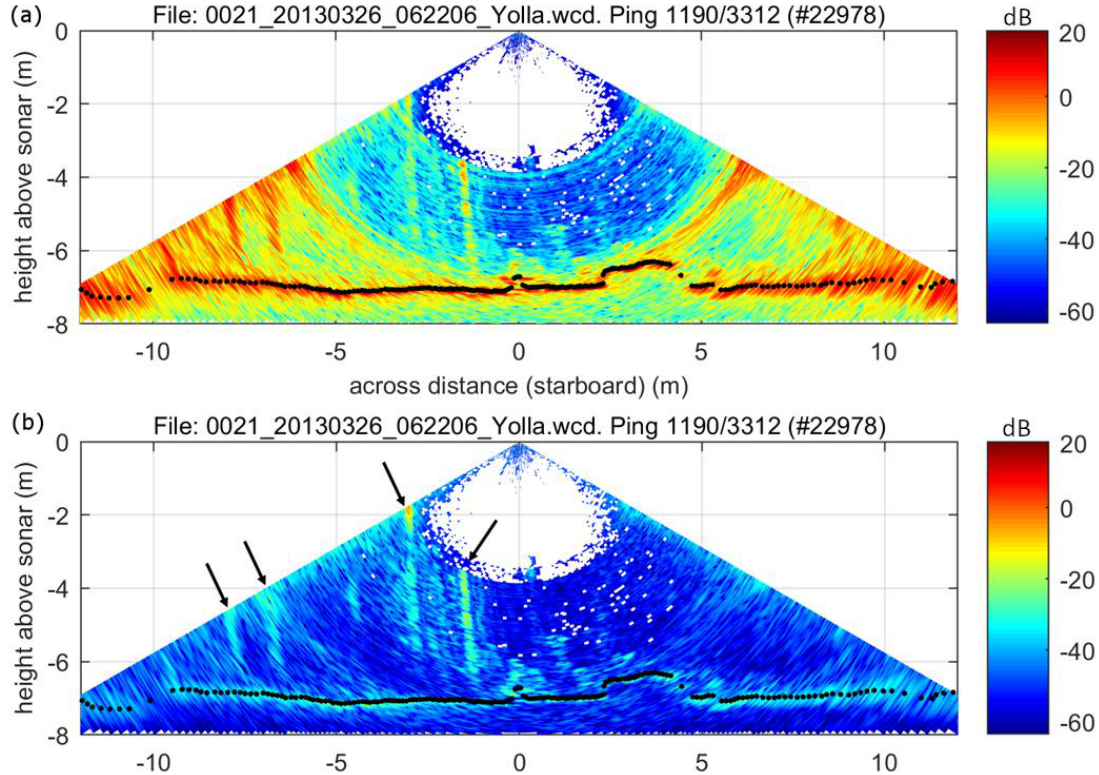
Figure 4. Illustration of EM 2040 C MBES water-column data acquired over naturally occurring giant kelp on a rocky reef: ( a ) before and ( b ) after application of the SRSN filter. The black arrows point at the near-vertical, high-intensity echoes extending from the seafloor through the water column, produced by giant kelp plants.